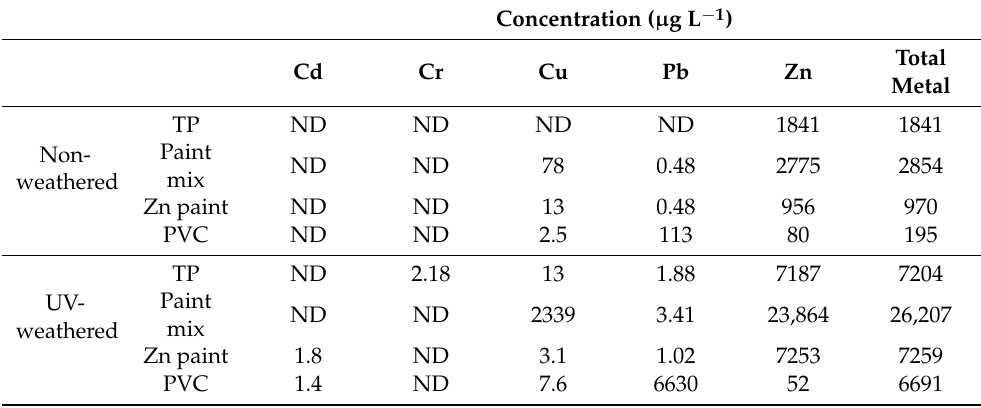
Table 3. The blank-corrected concentrations of inorganic elements measured in the concentrated leachates. Total metal refers to the sum of metal concentrations. ND denotes non-detected